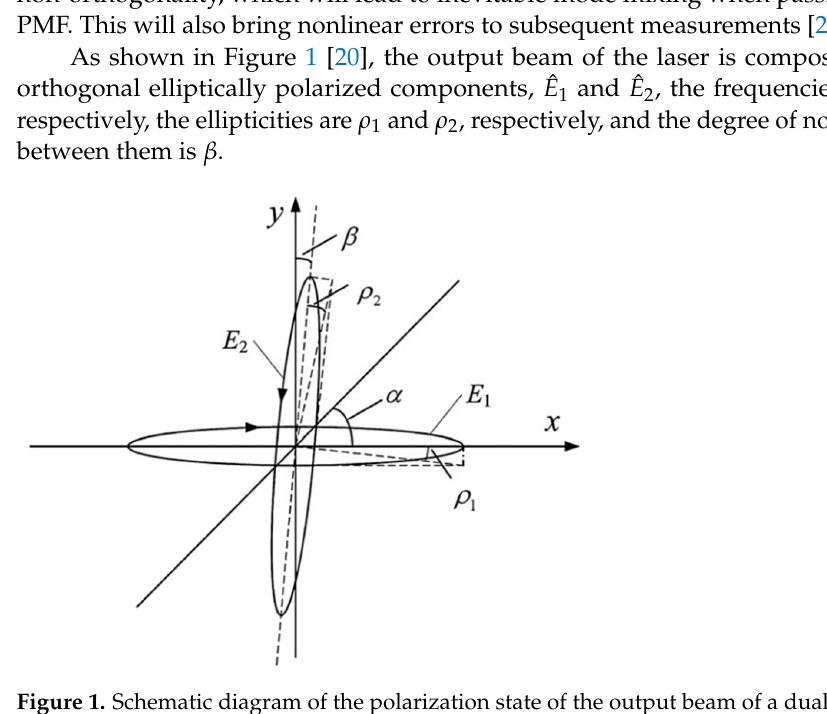
Figure 1. Schematic diagram of the polarization state of the output beam of a dual-frequency laser. Assuming that the x-axis of the coordinate system is parallel to 𝐸(cid:3552) (cid:2869) , the Jones